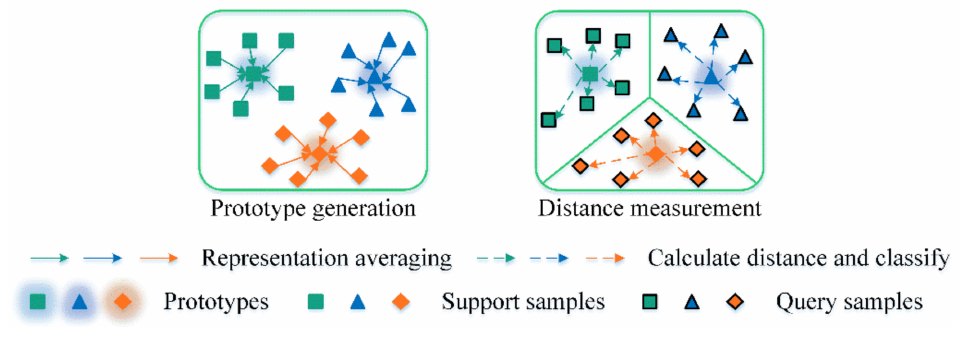
Figure 3. The scheme of